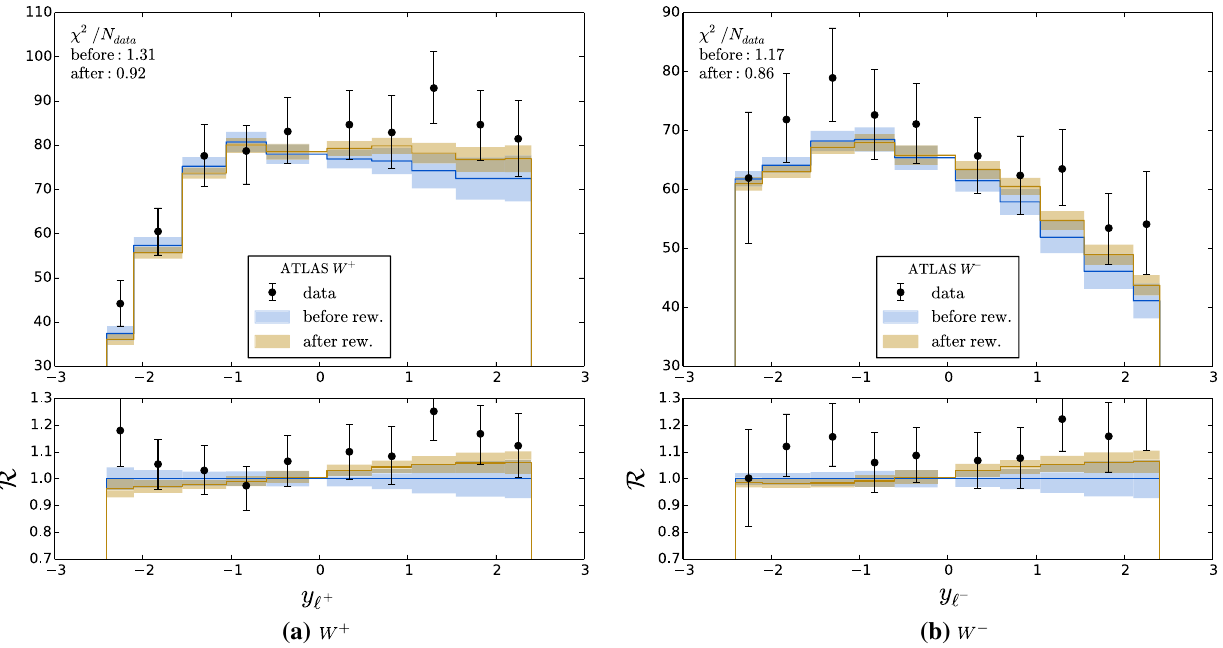
Fig. 26 Comparison of data and theory before and after the reweighting procedure using all LHC pPb data. The results for the ATLAS W + ( left ) and W − ( right ) distributions are